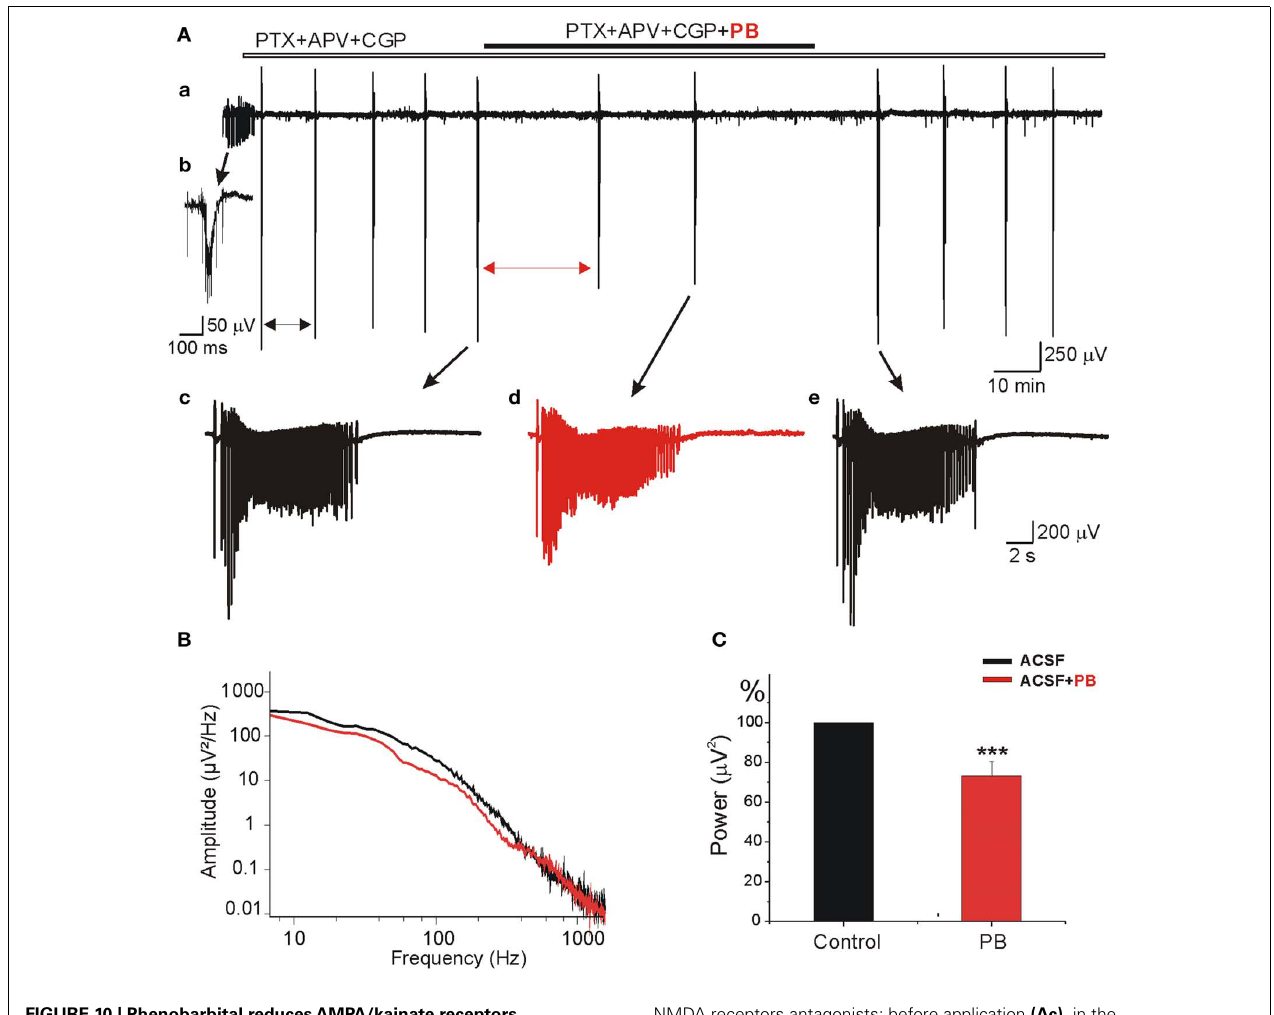
FIGURE 10 | Phenobarbital reducesAMPA/kainate receptors field potentials in mirror focus neurons. (A) Extracellular field recording of spontaneous epileptiform activities in slices obtained from contralateral hippocampus after mirror focus formation. Recordings were performed in the presence of GABA(A) and GABA(C) receptors antagonist PTX (100 μ M), GABA(B) receptor antagonist CGP (2 μ M), and NMDA receptor antagonist APV (40 μ M). (Ab) Example of epileptiform activities recorded in an “epileptic” slice from mirror focus before application of antagonists. (Ac–e) Examples of ILEs in the presence of GABA and